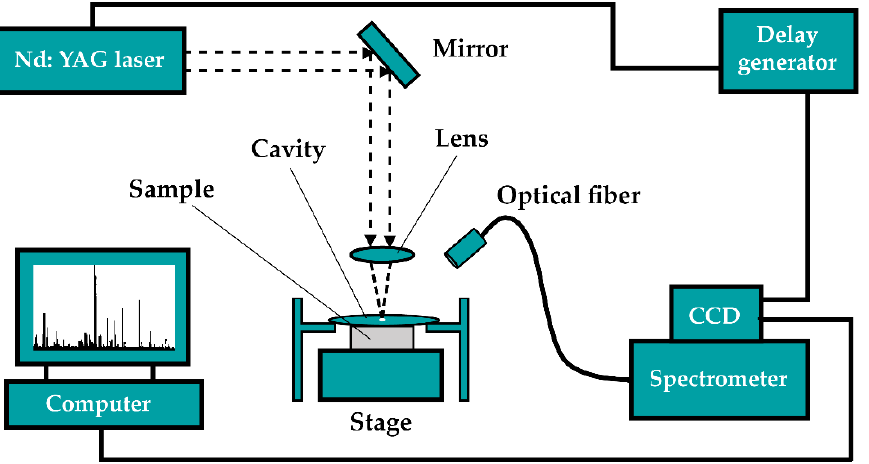
Figure 1. The LIBS experimental setup.